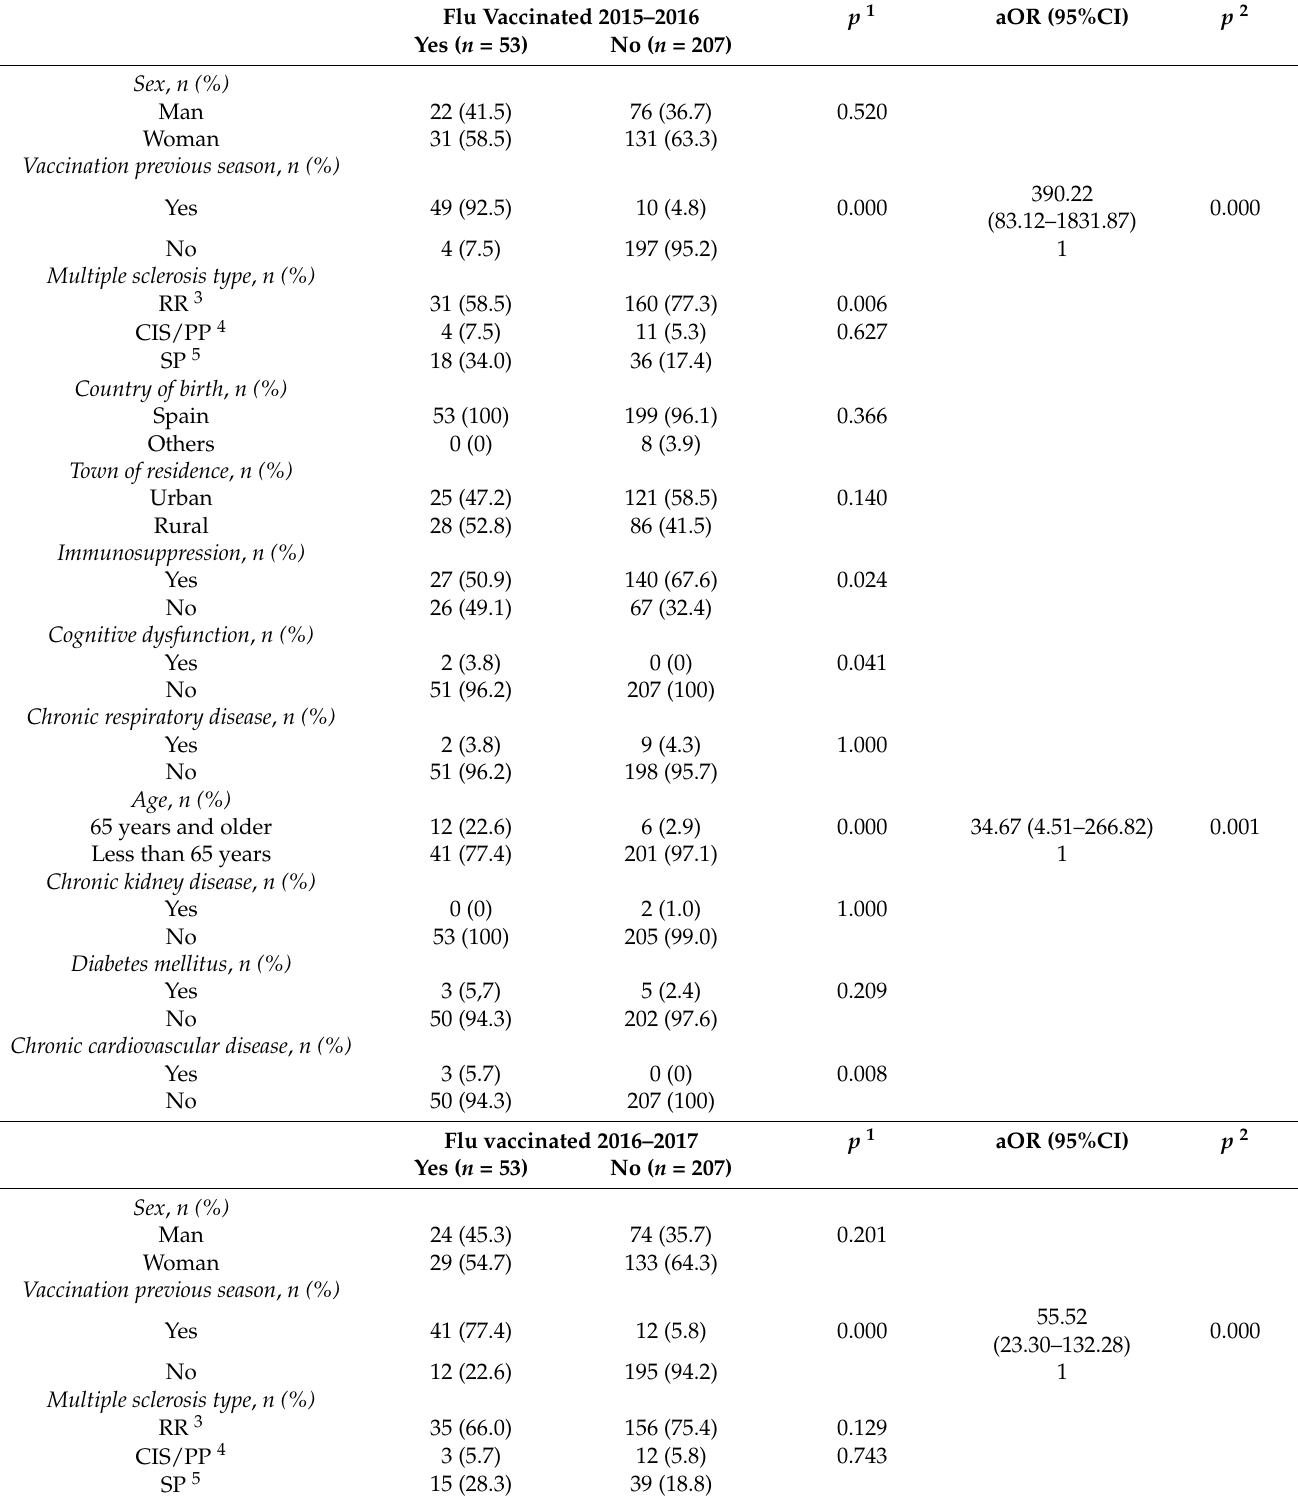
Table 5. Results of the bivariate analysis and variables included in the logistic regression